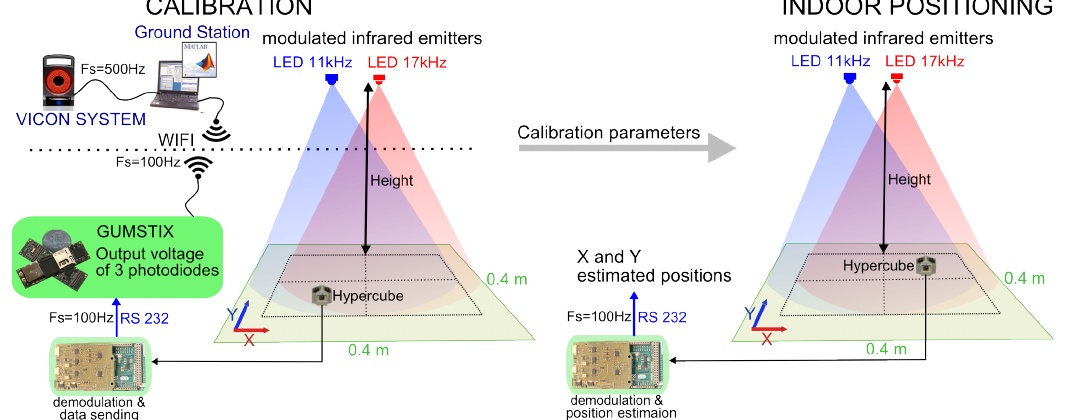
Figure 5. The principle of the indoor positioning solution at a fixed height consists of two steps: (i) the calibration procedure aims at finding the parameters which minimize the quadratic error metrics between the reference position given by the Vicon system and the data provided by the sensor; and (ii) given the calibration parameters, the sole use of the sensor device connected to the shielded demodulation board allows to estimate the positions X and Y at a fixed